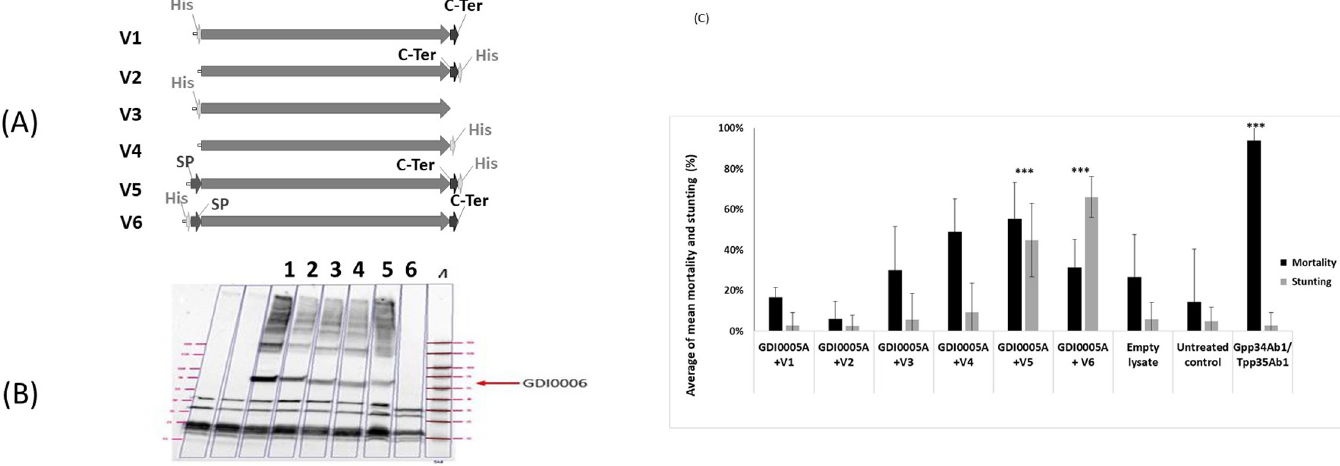
Fig 8. Expression and activity of GDI0006A. (A) Representation of GDI0006A new constructs. V1: signal peptide (SP) deleted, His-tag at the N-terminus; V2: signal peptide deleted and His-tag at C-terminus; V3: signal peptide deleted, C-terminal extension deleted, and His-tag at N-terminus; V4: signal peptide deleted, C-terminal extension deleted and His-tag at C-terminus; V5: full protein with a His-tag at the C-terminus; V6: full protein with a His-tag at the N-terminus (as in the original construct used in bioassays). (B) Western blot analysis of GDI0006A construct expression using an anti-His antibody. Lane 1 corresponds to the construct V1, lane 2 to construct V2, lane 3 to construct V3, lane 4 to construct V4, lane 5 to construct V5 and lane 6 to construct V6. (C) Activity of GDI0006A lysates from constructs (V1 to V6) mixed with GDI0005A lysates on WCR neonates 5 days after treatment and infestation using diet overlay bioassay. Activity was evaluated by assessing the percentage of mortality (black boxes) and the percentage of stunting (grey boxes). Each WCR larvae was exposed to ~200 μ L of WCR artificial diet overlaid with 20 μ L of bacterial lysate mixtures containing (GDI0005A + GDI0006A different constructs). Negative controls were lysates from E . coli bacteria transfected with the empty expression plasmid (empty lysate) and sterilized water (untreated control). The positive control was a lysate from bacteria transfected with a plasmid expressing the commercial Gpp34Ab1/Tpp35Ab1 binary proteins. Six 96-well plates each with 8 wells per treatment were used, totaling a sample size of 48 per treatment. A Fisher exact test was used to compare treatment results to the empty lysate at significance levels of P < 0.05 � , < 0.005 �� , < 0.001 ��� . The untreated control was only used to evaluate the quality and reliability of each